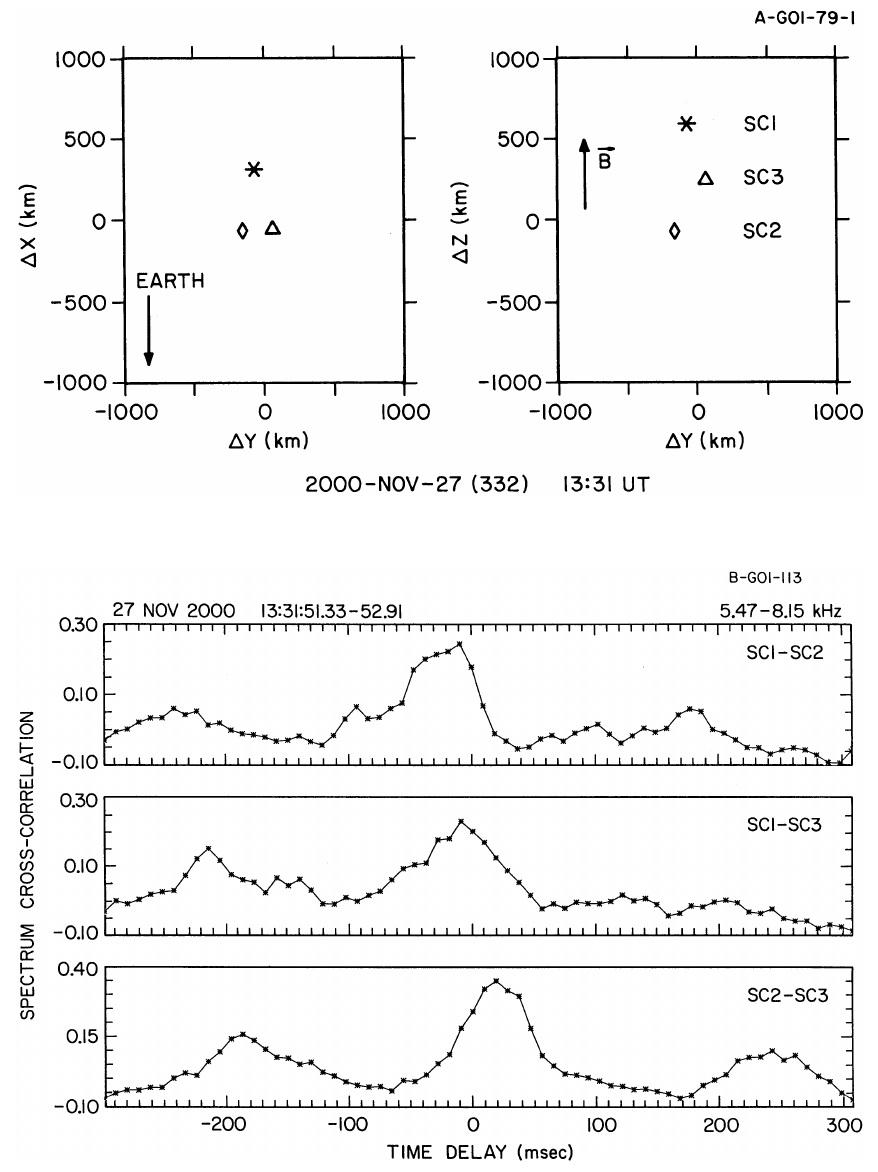
Fig. 11. The cross-correlation between the three spacecraft as a function of time delay for a selected time interval from the spectrogram in Fig. 7. The fre- quency and time ranges over which the cross-correlation was performed were 5.47 to 8.15kHz and 13:31:51.33 to 13:31:52.91UT. A positive time delay indicates that the signal arrives first at the spacecraft listed first in the identi- fier for each panel (i.e. SC2 in the bot- tom panel,